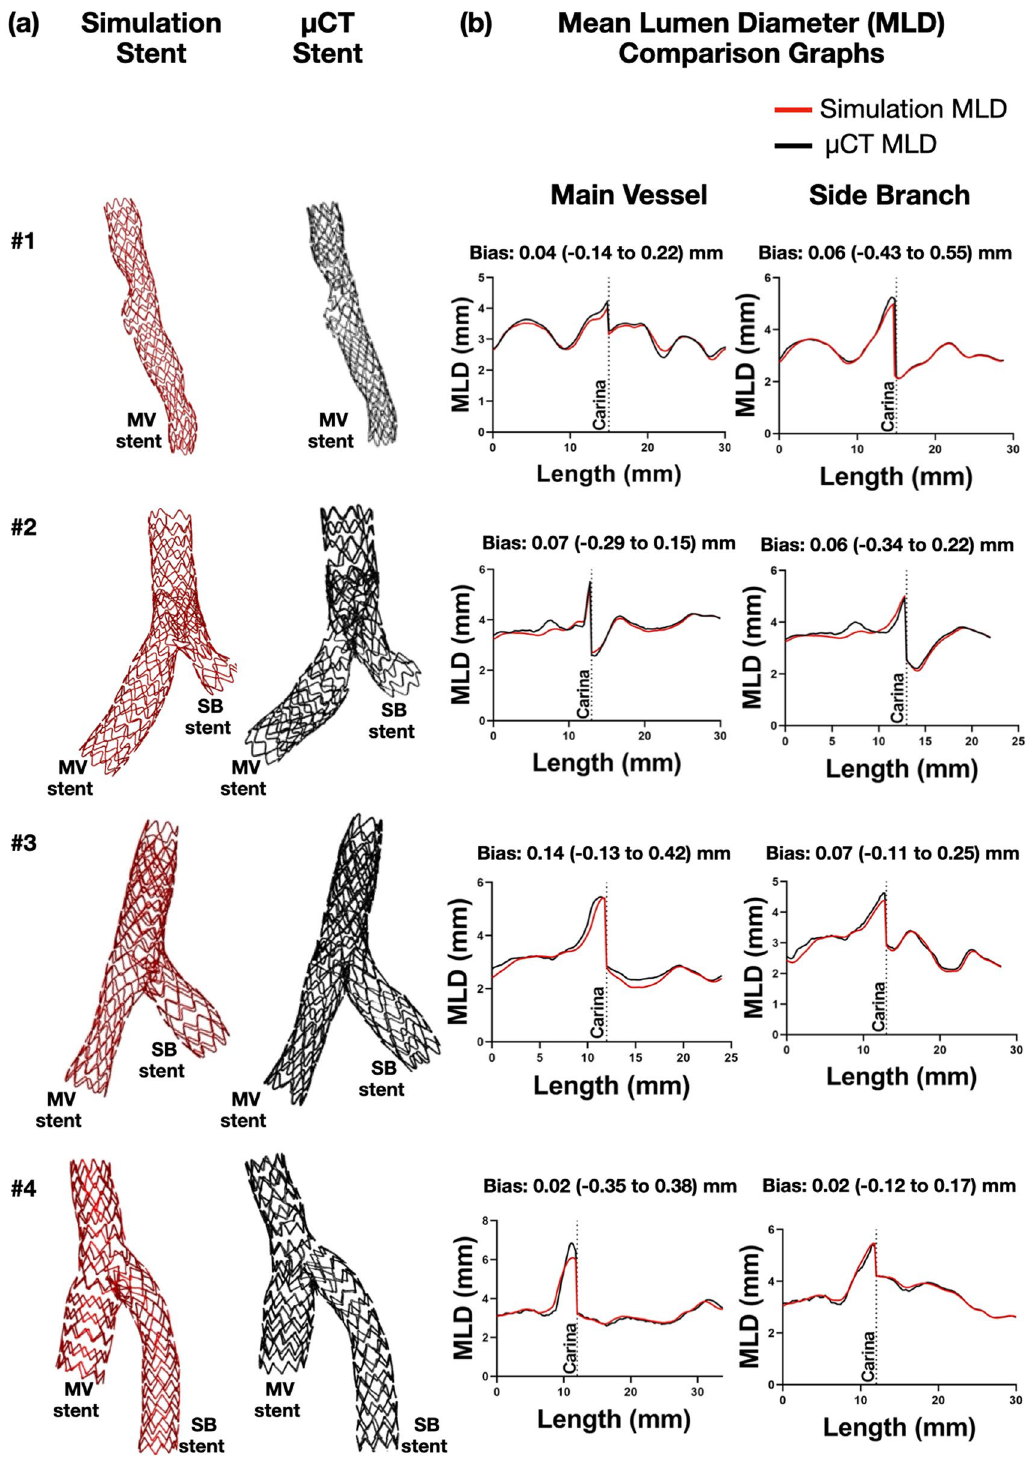
Figure 3. Computational stenting simulation versus µCT (Bench cases). Qualitative ( a ) and morphometric ( b ) comparison of computational stenting simulations against bench stenting imaged by μCT. Graphs show the stented part of the lumen only. Bias refers to the average difference in mean lumen diameters (MLD; 95% limits of agreement) between methods by Bland–Altman analysis; MV main vessel, SB side branch, µCT micro- computed